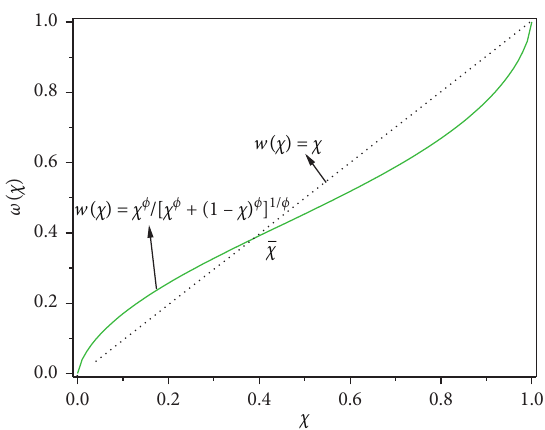
Figure 2: The curve of the probability weighting